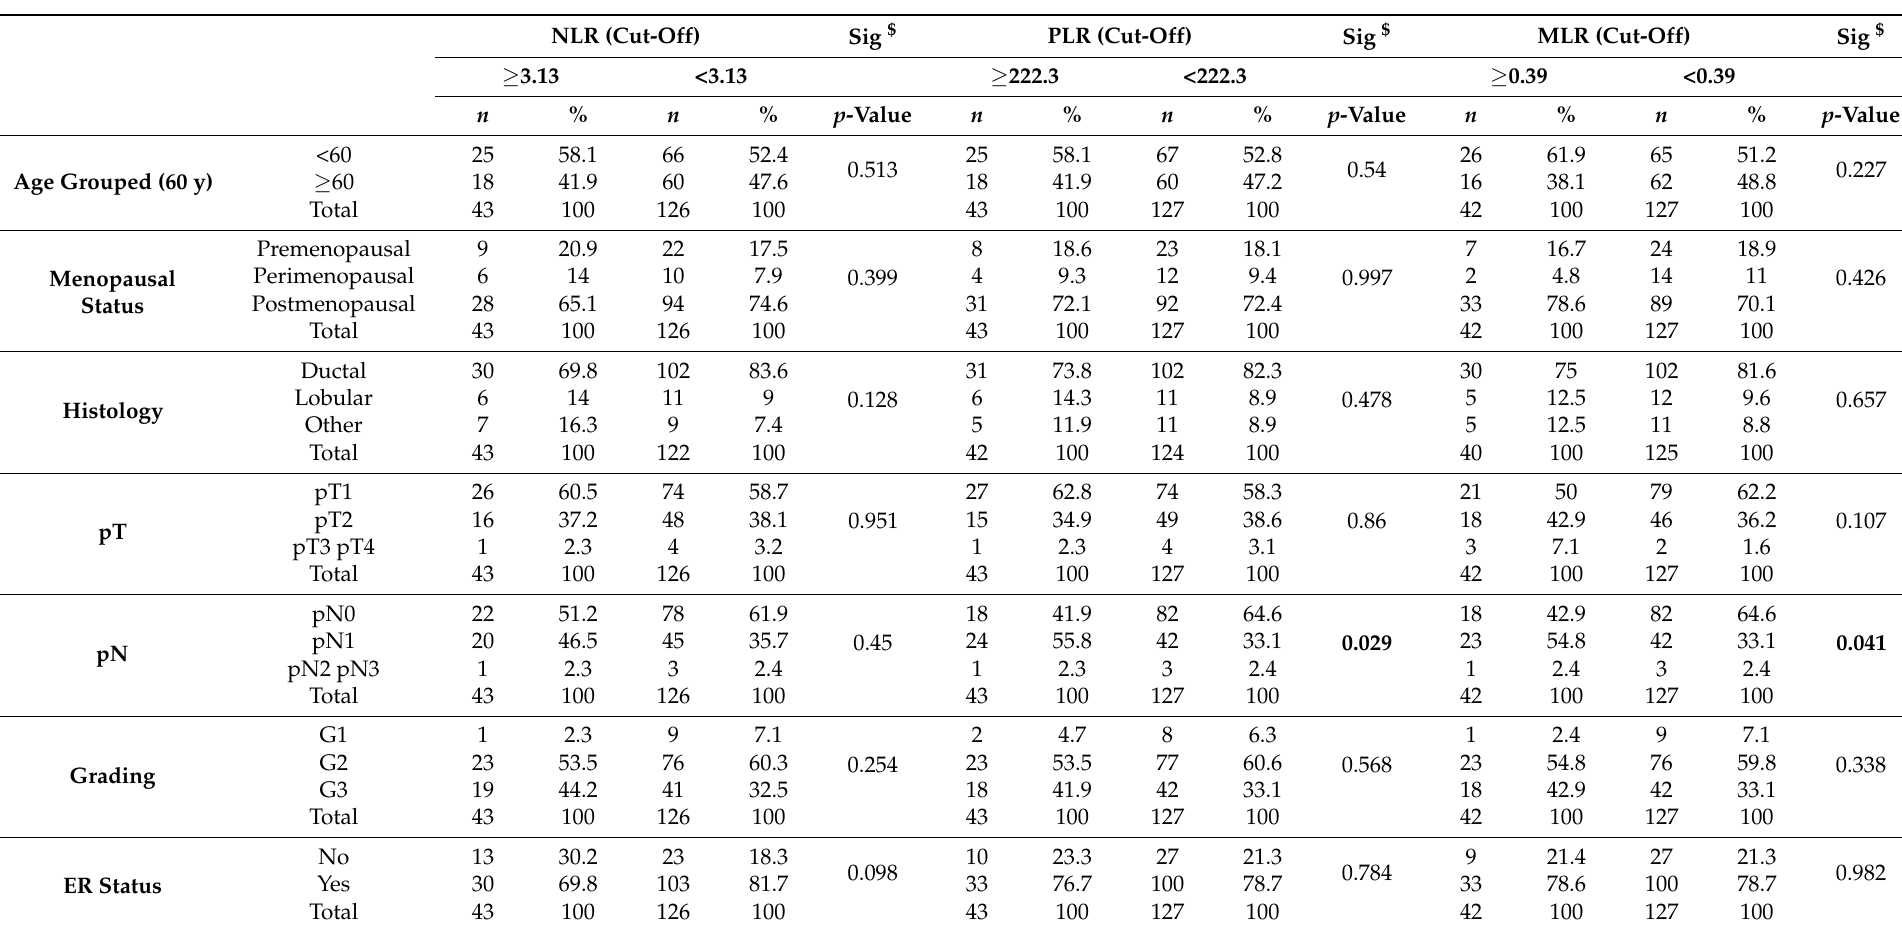
Table 3. Correlation of NLR, PLR and MLR with clinical characteristics. CTCs: circulating tumor cells; DTCs: disseminated tumor cells; ER: estrogen receptor;